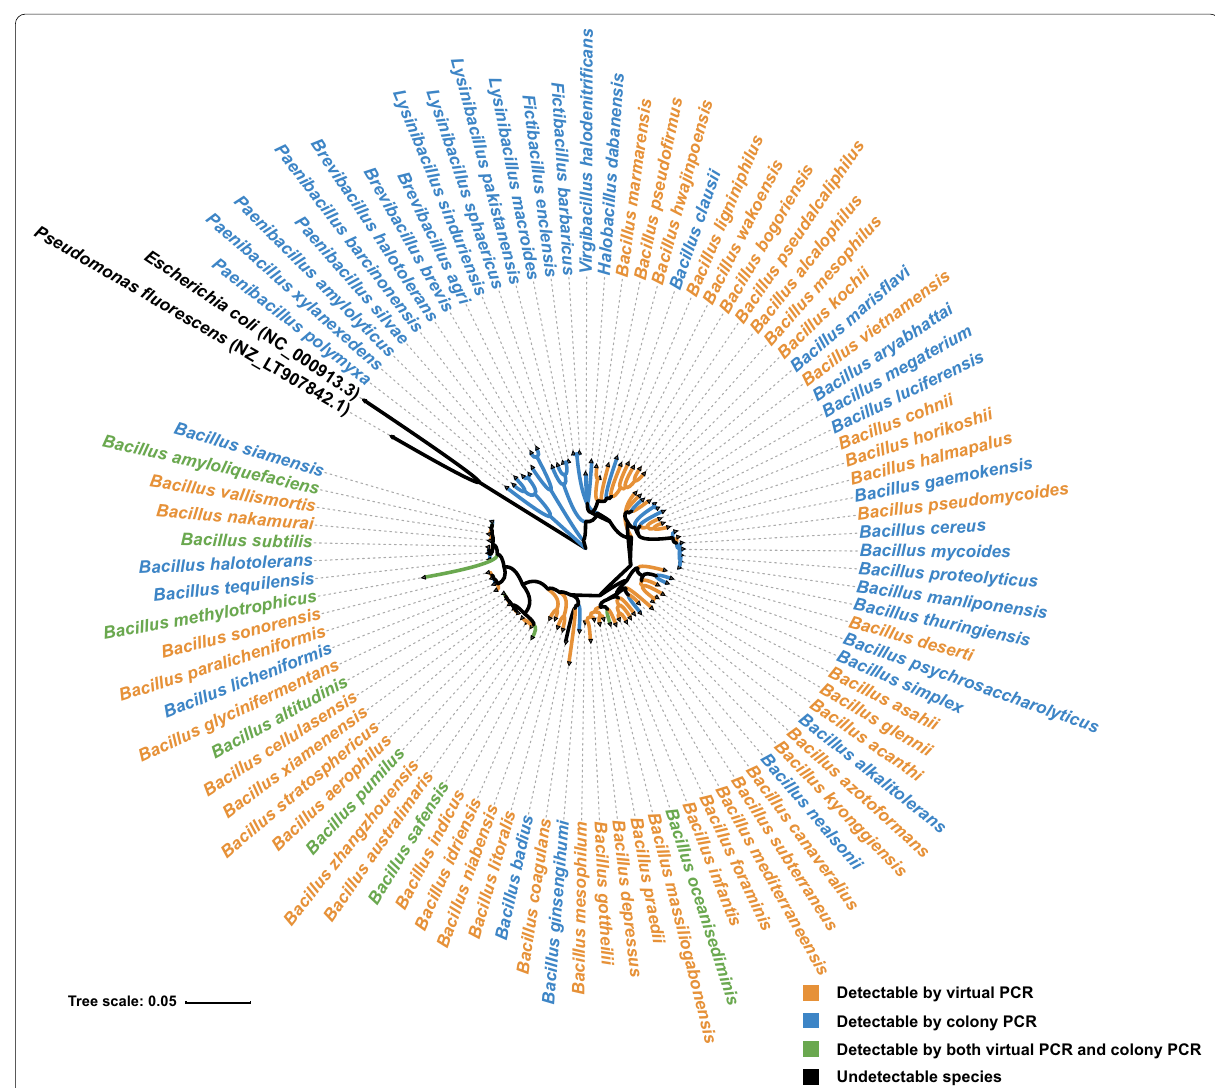
Fig. 3 The amplification ability of the primer pair gyrA 3 of Bacillus species and related species performed by computer simulation and in situ amplification. The Bacillus species indicated by the orange color (48 species) represent the species in the database that were matched by gyrA 3 only in virtual PCR. The Bacillus species in blue color represented strains that can be amplified by gyrA 3 only by colony PCR. These strains included 21 Bacillus species and 16 Bacillus ’s related genera species. The Bacillus species in green color (7 species) represent strains that can be amplified by two methods: virtual PCR and colony PCR. The species in black color (2 species) represent strains that cannot be amplified in virtual PCR nor by colony PCR. The phylogenetic tree was constructed based on 16S rRNA (1302